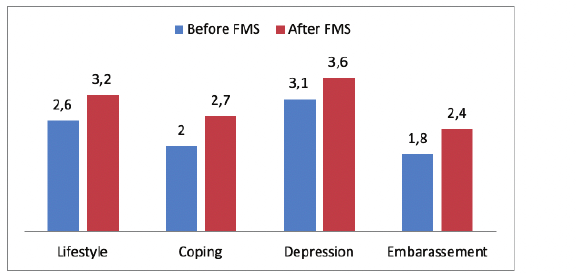
Figure 3: Modifications of the four domains of FiQL after FMS